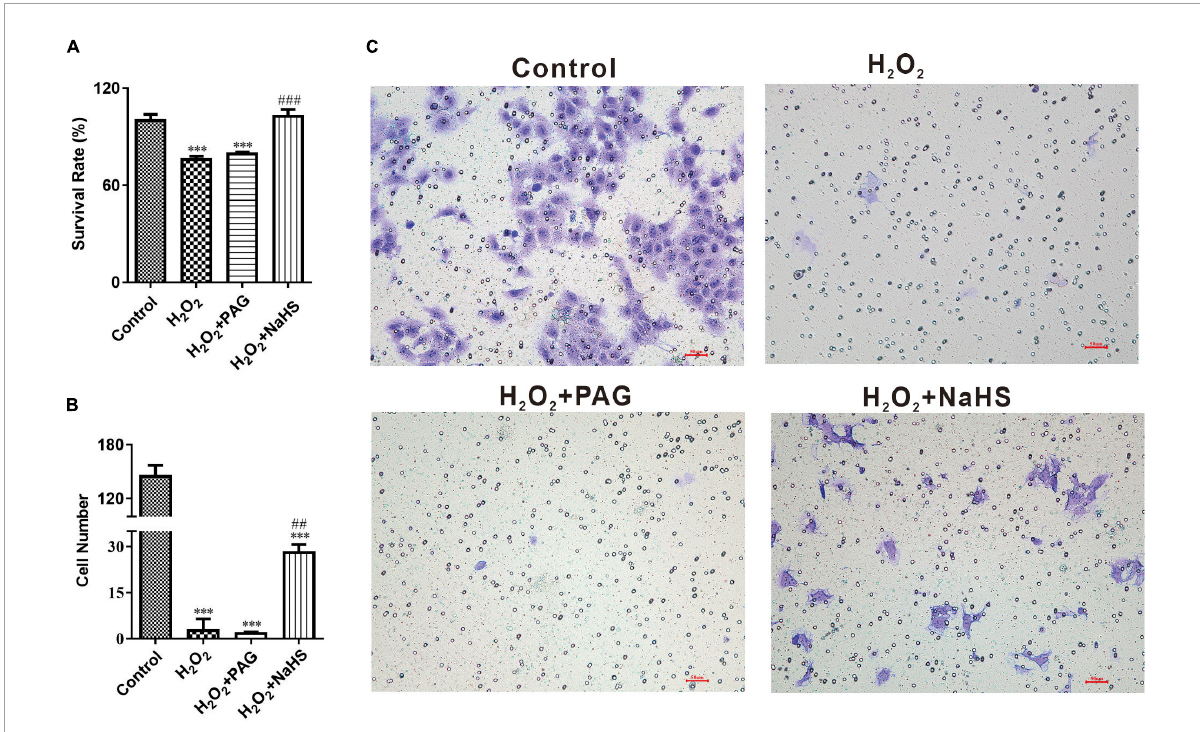
FIGURE3 NaHS induced HTR-8/SVneo cells invasion and proliferation. (A) Summarize of survival rate of HTR-8/SVneo cells after different treatments. (B) Summarize cell number detected by invasion assay. (C) Representative picture of HTR-8/SVneo cells stained with crystal violet. The data